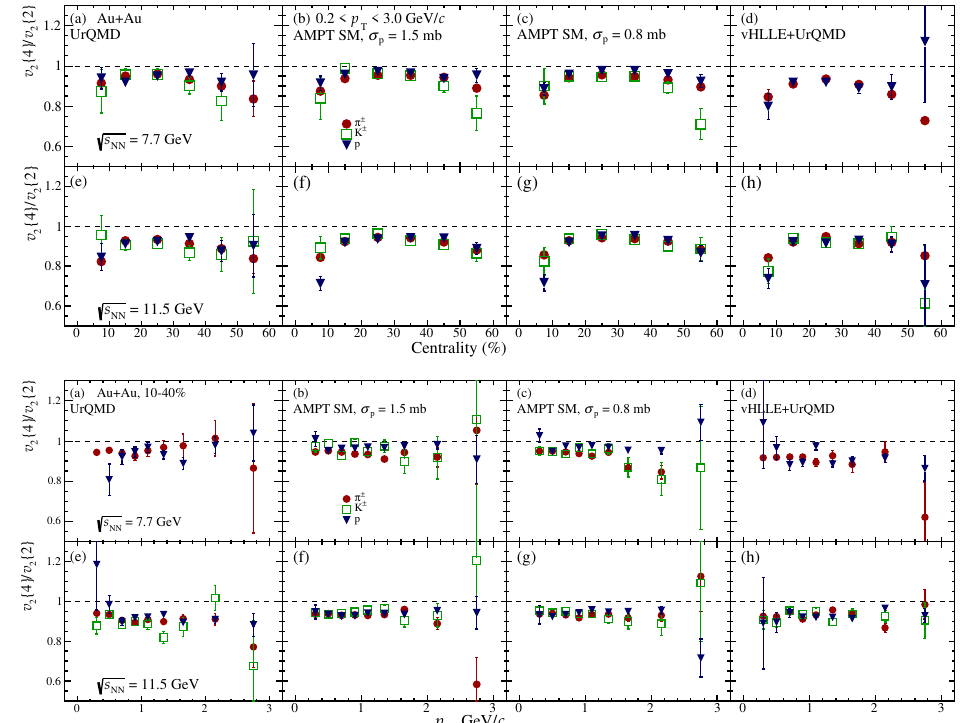
Figure 6. Centrality and p T dependences of relative elliptic flow fluctuations v 2 { 4 } / v 2 { 2 } of iden- √ s NN = 7.7 GeV ( a – d ) and 11.5 GeV ( e – h ). Columns tified hadrons from Au+Au collisions at correspond to different used